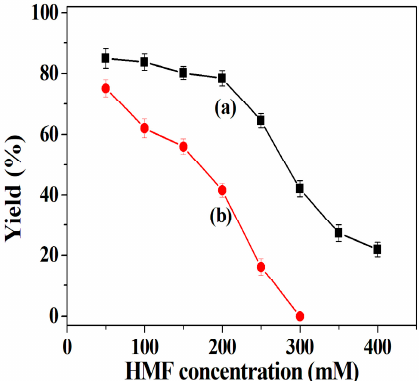
Figure 3. Effect of HMF concentration on DFF yield: co-immobilized tri-enzymes ( a ) and free tri- enzymes ( b ). Reaction conditions: deionized water; 25 °C; at different HMF concentrations from 50 mM to 400 mM. Free tri-enzymes (20 U of galactose oxidase, 8000 U of catalase and 500 U of horseradish peroxidase) and 35 mg of co-immobilized tri-enzymes were utilized in parallel experiments, respectively.